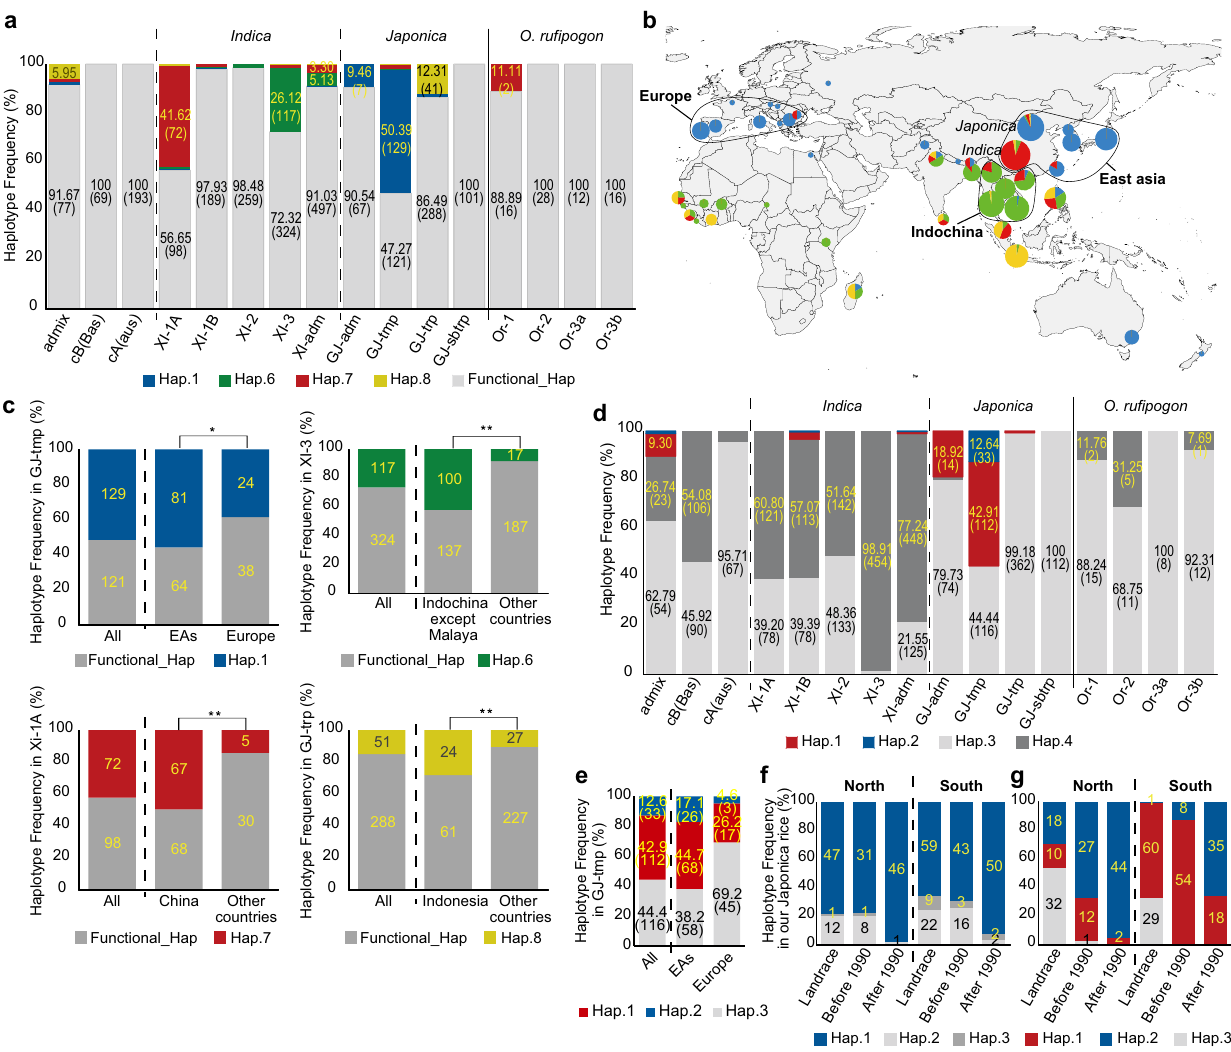
Fig. 5 | Distribution and transition of loss-of-function (LOF) haplotypes of GF14h and qLTG3 . a Haplotype frequency of GF14h among subpopulations of domesticated and wild rice. Four LOF haplotypes are present, while all func- tional haplotypes are combined as “ Functional_Hap ” . Frequency of all haplo- types is shown in Supplementary Fig. 17b. Numbers in bars represent percentage and the number of accessions in parentheses. Hap.7 and Hap.8 were con fi rmed by directly checking the alignment of reads by the Integrative Genomics Viewer (https://software.broadinstitute.org/software/igv/). b Geographical distribution of the GF14h LOF haplotypes. Ratio of each LOF to